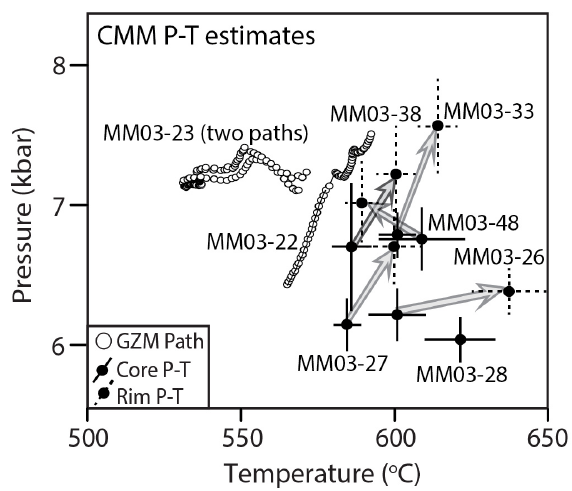
Figure 2. A compilation of garnet P-T estimates for rocks from the Central Menderes Massif. All estimates here are made using the GZM approach (P-T path modeling and core/rim isopleth thermobarometry). Error bars for core/rim estimates are based upon the region of P-T space, which garnet isopleths overlapped. This figure is modified from [23].